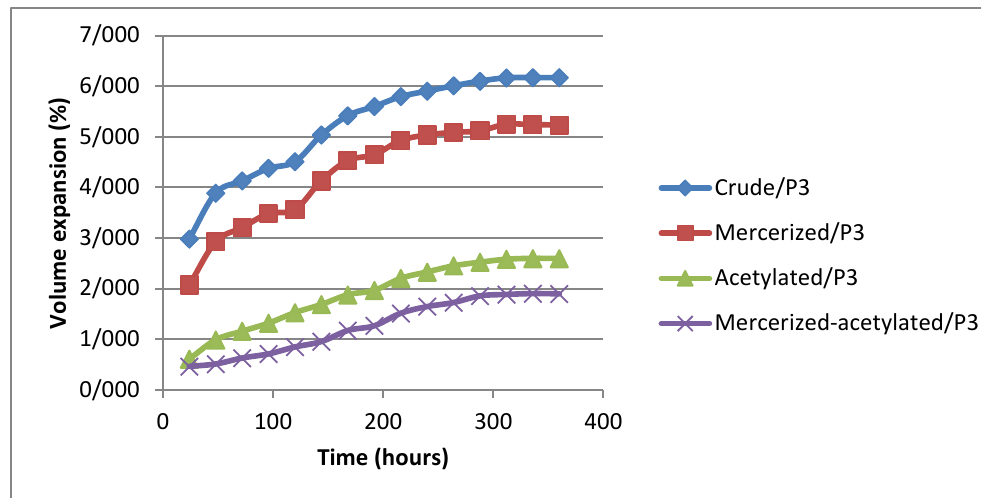
Fig. 19. Volume expansion due to moisture absorption at P2 fibre content